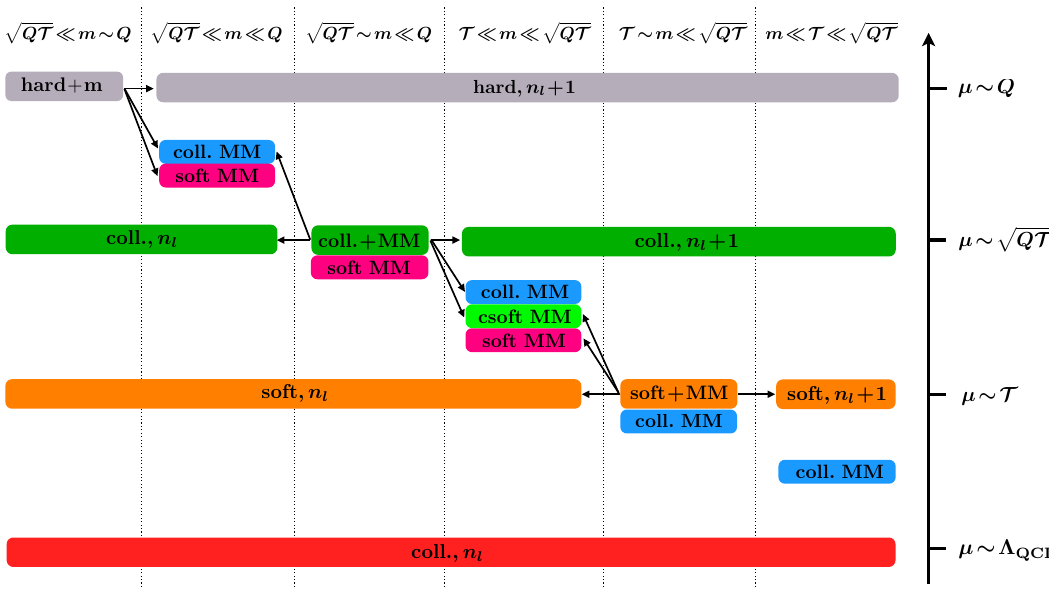
Figure 7 . Relevant modes for the beam thrust spectrum with between the quark mass m and the scales between the modes and their associated